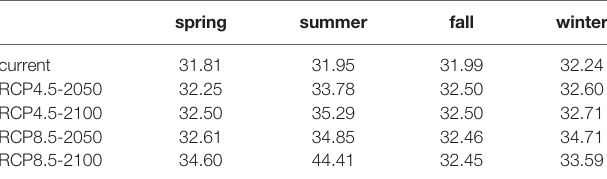
TABLE 3 | Latitude changes in the distribution centroid of Scomberomorus niphonius under future climate scenarios.